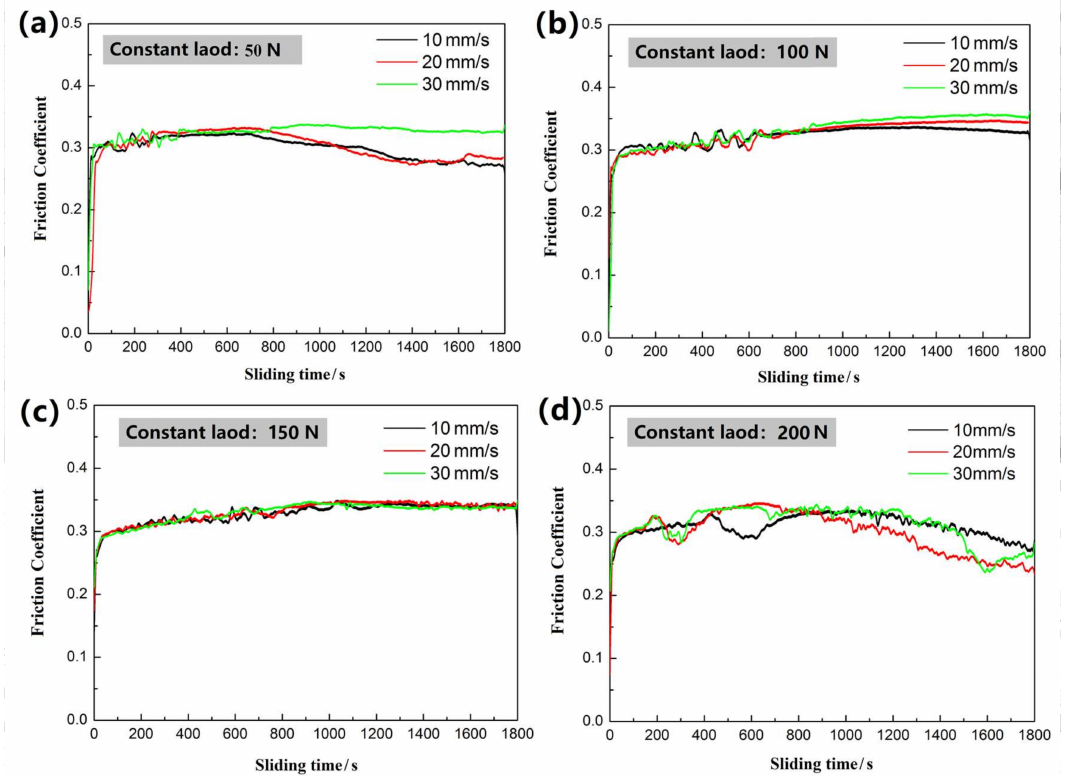
Figure 9. The friction coefficient curves tested at the different load and sliding speed. ( a – d ) are 50 N, 100 N, 150 N, and 200 N, respectively.